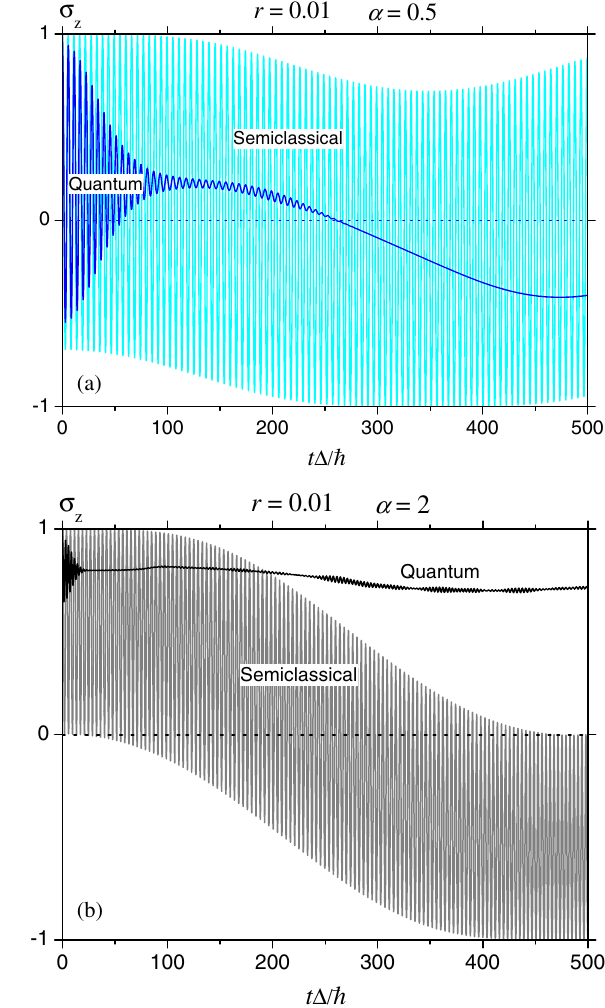
i within quantum and semi- z t